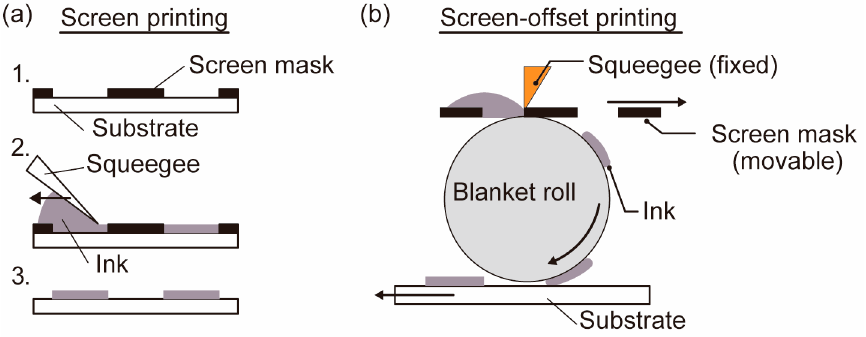
Figure 2. The process outline of ( a ) screen printing and ( b ) screen offset printing.